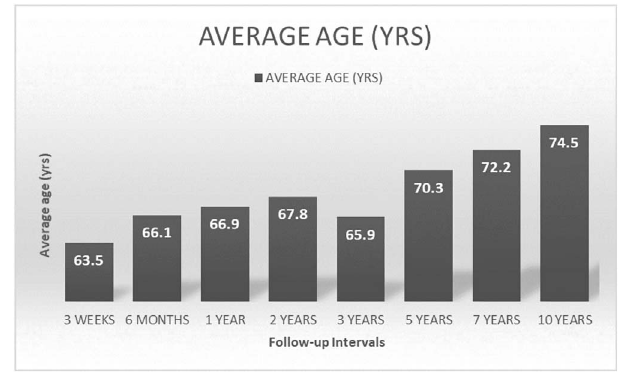
Figure 3. Average age of the study group at each follow-up